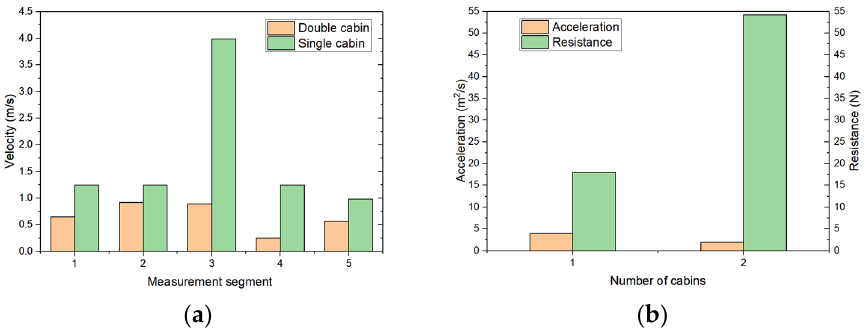
Figure 32 . Movement speed of the robots in di ff erent cabins: ( a ) Di ff erent types of robots vary in Figure 32. Movement speed of the robots in different cabins: ( a ) Different types of robots vary in speed at di ff erent positions; ( b ) Acceleration and resistance for di ff erent types of robots. speed at different positions; ( b ) Acceleration and resistance for different types of